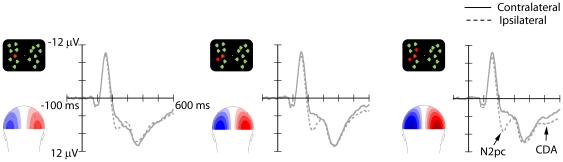
Grand-average ERP waveforms obtained in Experiment 1 in the 600 ms post-stimulus interval at posterior electrodes PO7/PO8 contralateral (solid lines) and ipsilateral (dashed lines) to the target hemifield, as a function of target numerosity (left column: one-target condition; middle column: two-target condition; right column: three-target condition).Topographical ERP scalp distribution maps of the N2pc (180–270 ms) are shown for each condition, obtained by computing the contralateral minus ipsilateral difference activity, and mirrored across the midline. The scale was optimized for each experiment (Experiment 1: ±4 µV). Both the N2pc and CDA increased as a function of target numerosity.